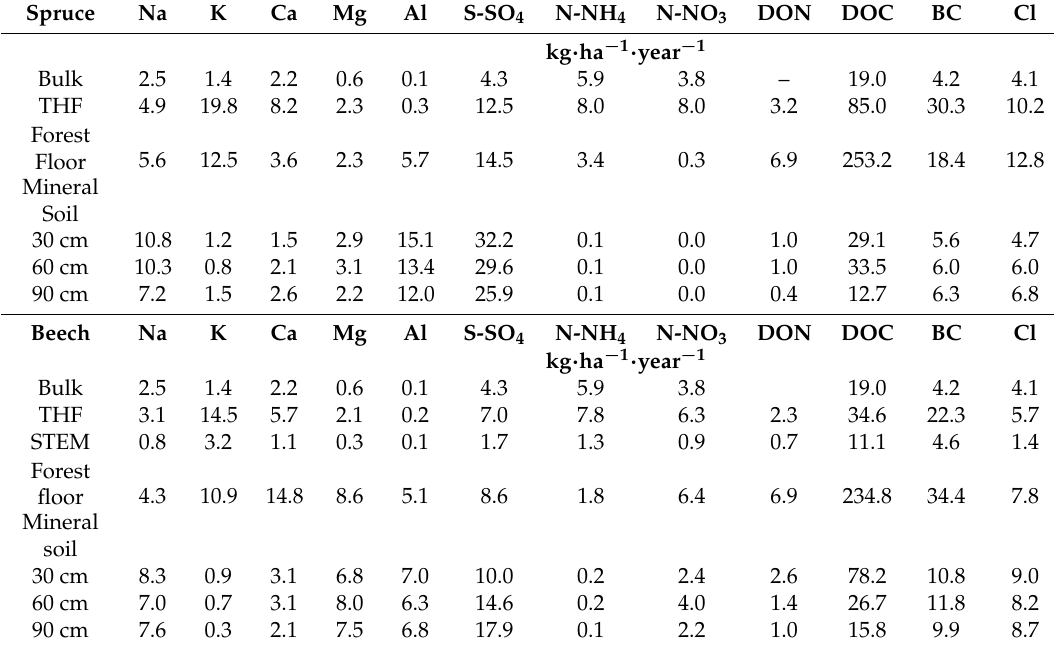
Table 3. Selected mean annual element fluxes in spruce and beech stands. Base cation (BC) is the sum of K + Ca +